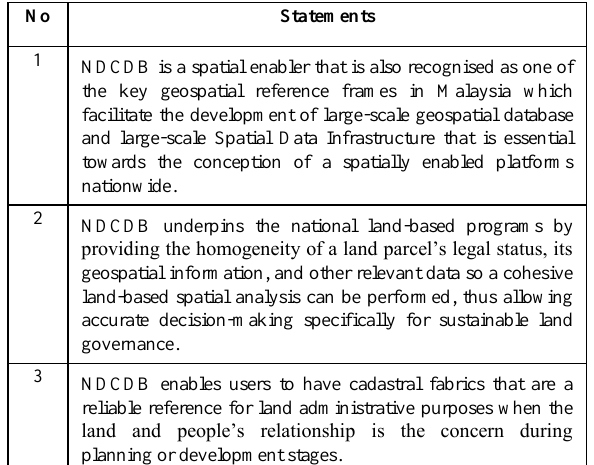
Table 2. Round 2 statements on NDCDB‘s significant role in Malaysia